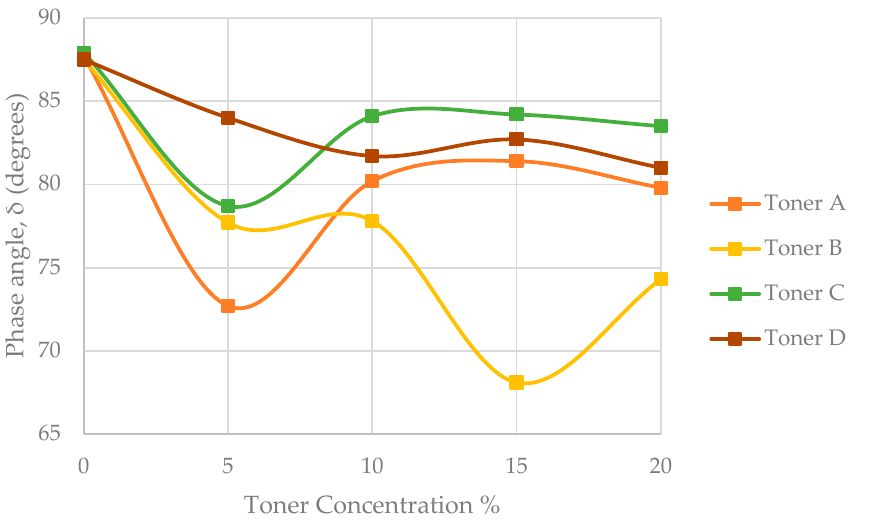
Figure 5. The influence of % toner concentration on phase angle ( δ ) for waste toners A, B, C, and D, measured at 1.59 Hz and 60 °C.